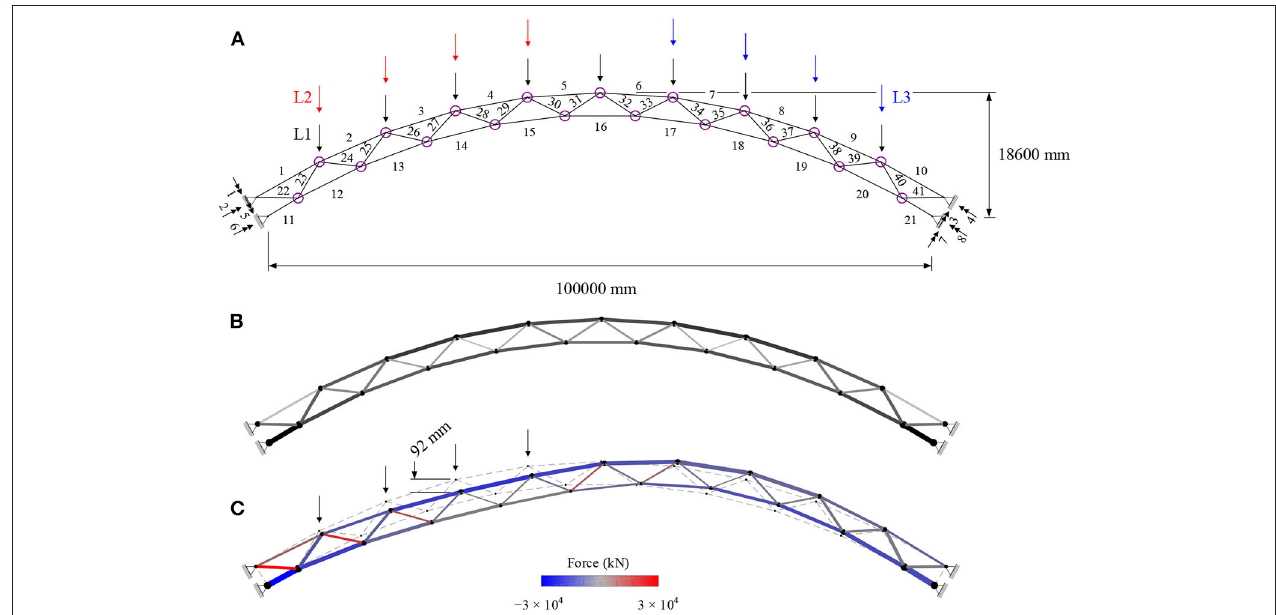
FIGURE 4 | Arch bridge: (A) dimensions, controlled nodes, and loading; (B) adaptive; (C) deformed shape and element forces under LC2 before control (magnification × 20).